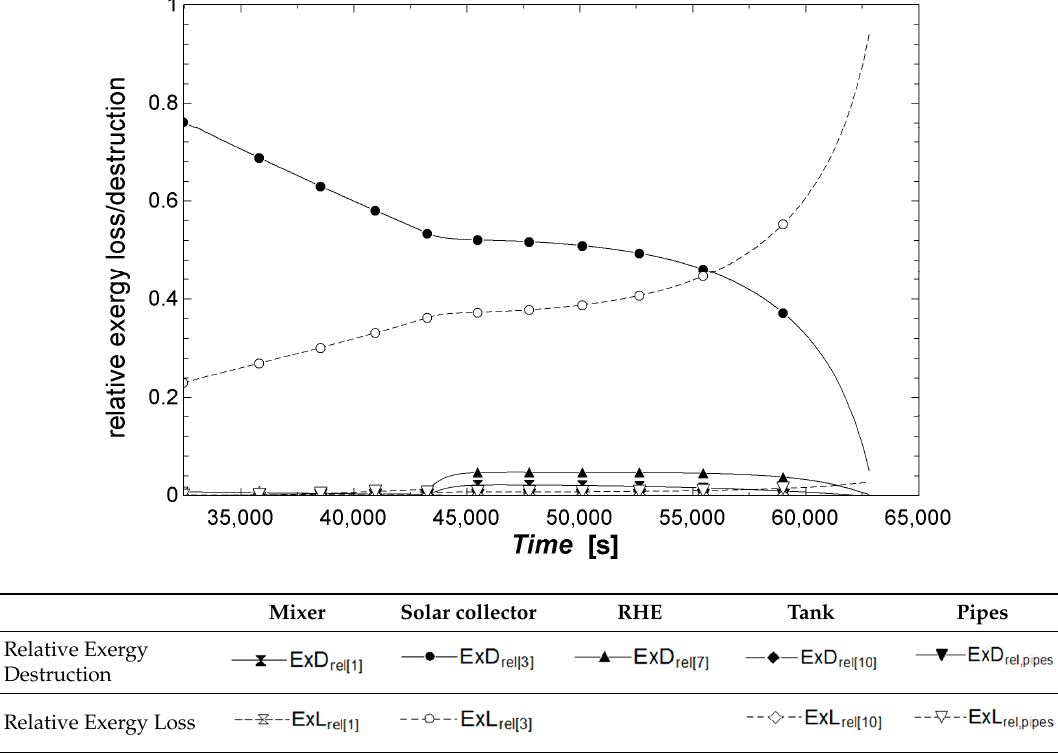
Figure 5. Daily profile of relative exergy destructions and losses within the components; Manila during reference day of May.